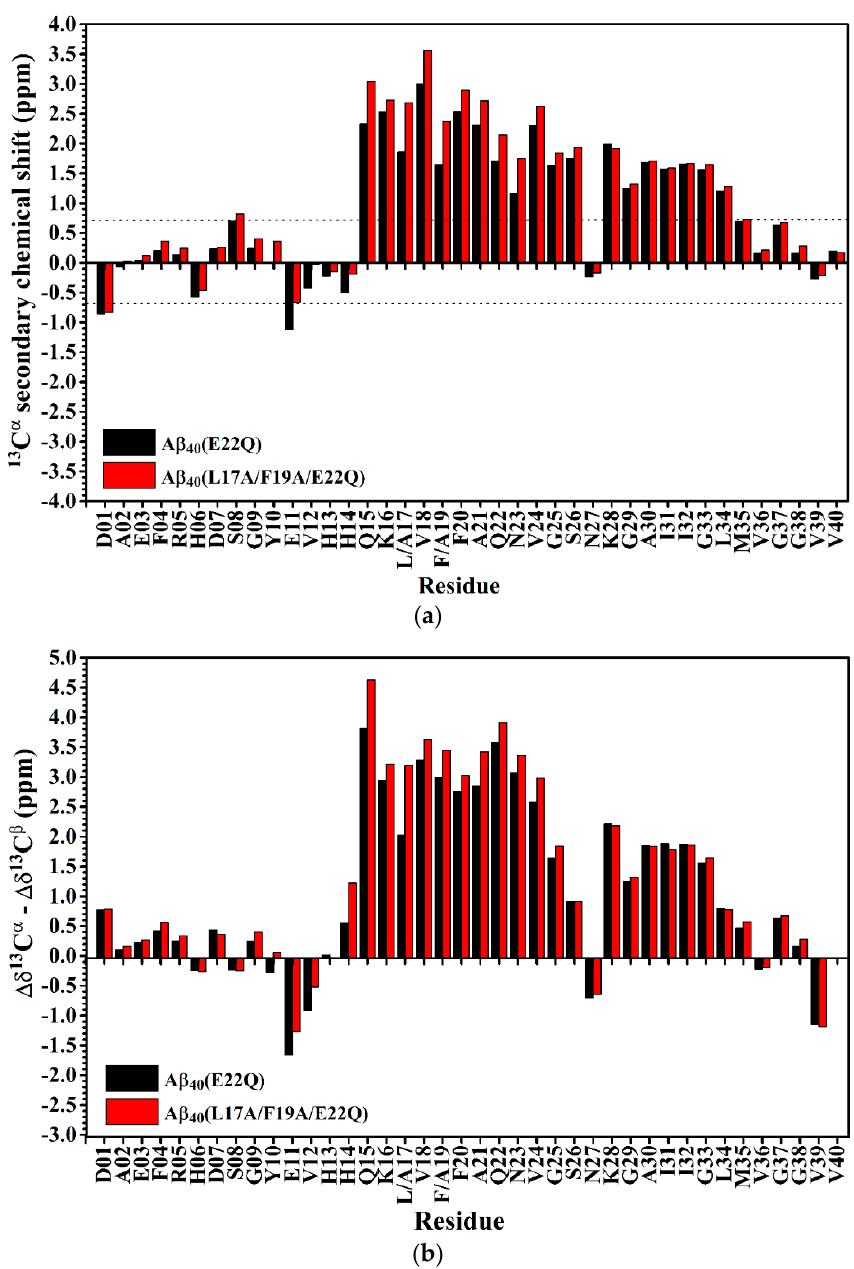
Figure 6. ( a ) 13 C α secondary chemical shifts of A β 40 (E22Q) (black) and A β 40 (L17A/F19A/E22Q) (red) plotted as a function of residue. In principle, if the 13 C α secondary chemical shift of an amino acid residue is greater than 0.7 ppm, its conformation would be α -helical [35]; ( b ) Differences between Δδ 13 C α ( 13 C α secondary chemical shift) and Δδ 13 C β ( 13 C β secondary chemical shift) of A β 40 (E22Q) (black) and A β 40 (L17A/F19A/E22Q) (red) plotted as a function of residue. Δδ 13 C α (or Δδ 13 C β ) was defined as the difference between the observed 13 C α (or 13 C β ) chemical shift of an amino acid residue and its 13 C α (or 13 C β ) chemical shift in a random coil conformation. If Δδ 13 C α – Δδ 13 C β for an amino acid residue is positive, its conformation would be α -helical. For a more detailed description of the relationship between the value of Δδ 13 C α – Δδ 13 C β and secondary structure of an amino acid residue please see the reference [34].